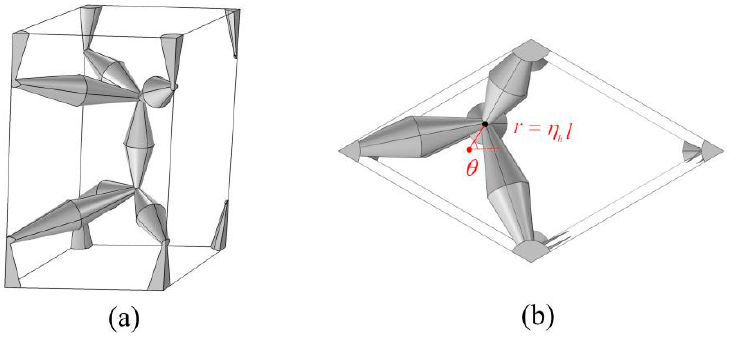
Figure 6. The primitive cell with connection points P 1 and P 2 moving in the same horizontal direction ( a ) primitive cell ( b ) positions of the connection points.